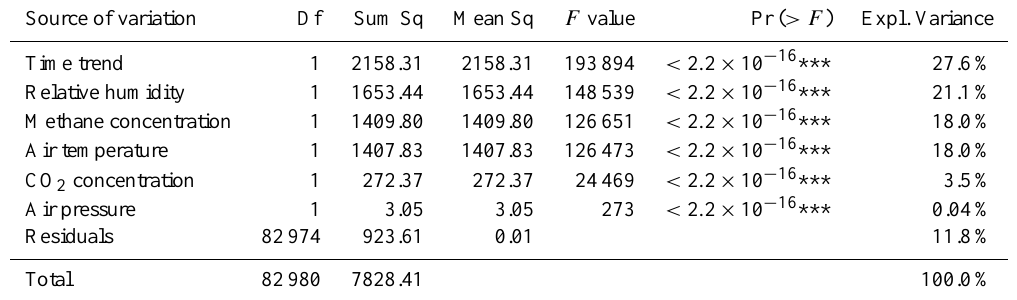
Table 2. Same analysis as in Table 1, but with the inclusion of CO 2 concentrations and atmospheric pressure as a potential source of variation. Source of